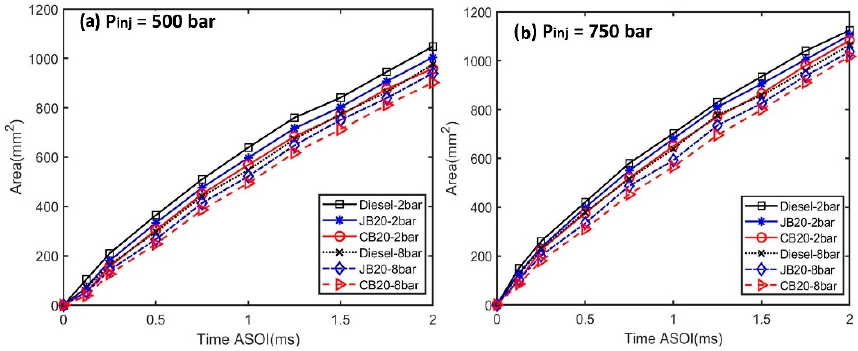
Figure 12. Experimental results for ( a ) spray area at 500-bar IP. ( b ) Spray area at 750-bar